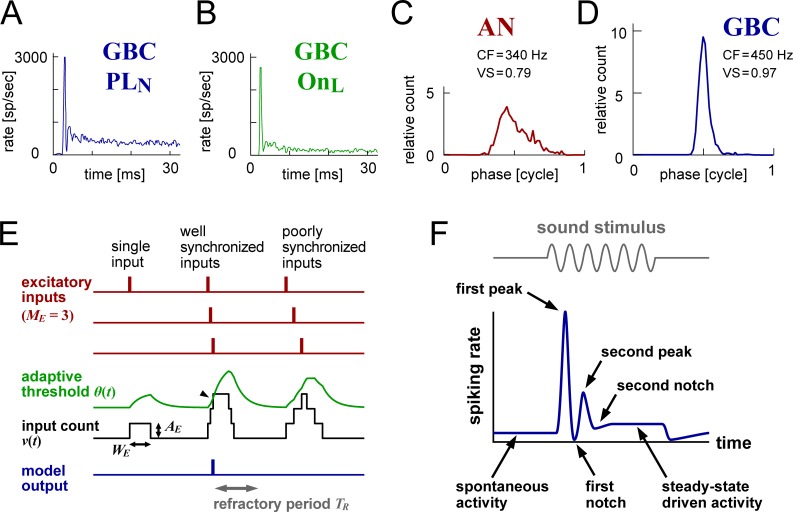
Empirical response patterns of GBC and schematic drawings of the model structure and PSTH output.A-B: PSTHs of cat GBCs: a PLN-type (A) and an OnL-type (B). Adapted from [24]. C-D: Low-frequency phase histograms of a cat auditory nerve (C) and GBC (D). Adapted from [25]. CF: characteristic frequency; VS: vector strength. E: Operation of the adaptive coincidence counting model (see Materials and Methods for the equations). The model neuron receives ME excitatory synaptic inputs (red) simulated by the AN model (ME = 3 in this example). Each presynaptic input spike (small vertical red bar) induces a postsynaptic response of a length WE and amplitude AE in the model neuron (black rectangular bump on left). The adaptive threshold θ(t) (green), parameterized by a time scale TA and strength SA, develops according to the summed input count v(t) (black). When the input count reaches or exceeds the threshold (arrowhead), an output spike is generated (blue). After each spike output, the model is in the refractory period of a duration TR (gray), in which no further spikes can be generated. Insufficient synchrony of input spikes (three inputs on right) leads to a failure of output spike generation due to the adaptive threshold. F: Components of a primary-like-with-notch (PLN) peristimulus time histogram (PSTH) used for judging the plausibility of each instance of the modeled bushy cell. Depending on the parameters used, a second notch may or may not exist while the other components almost always appear.